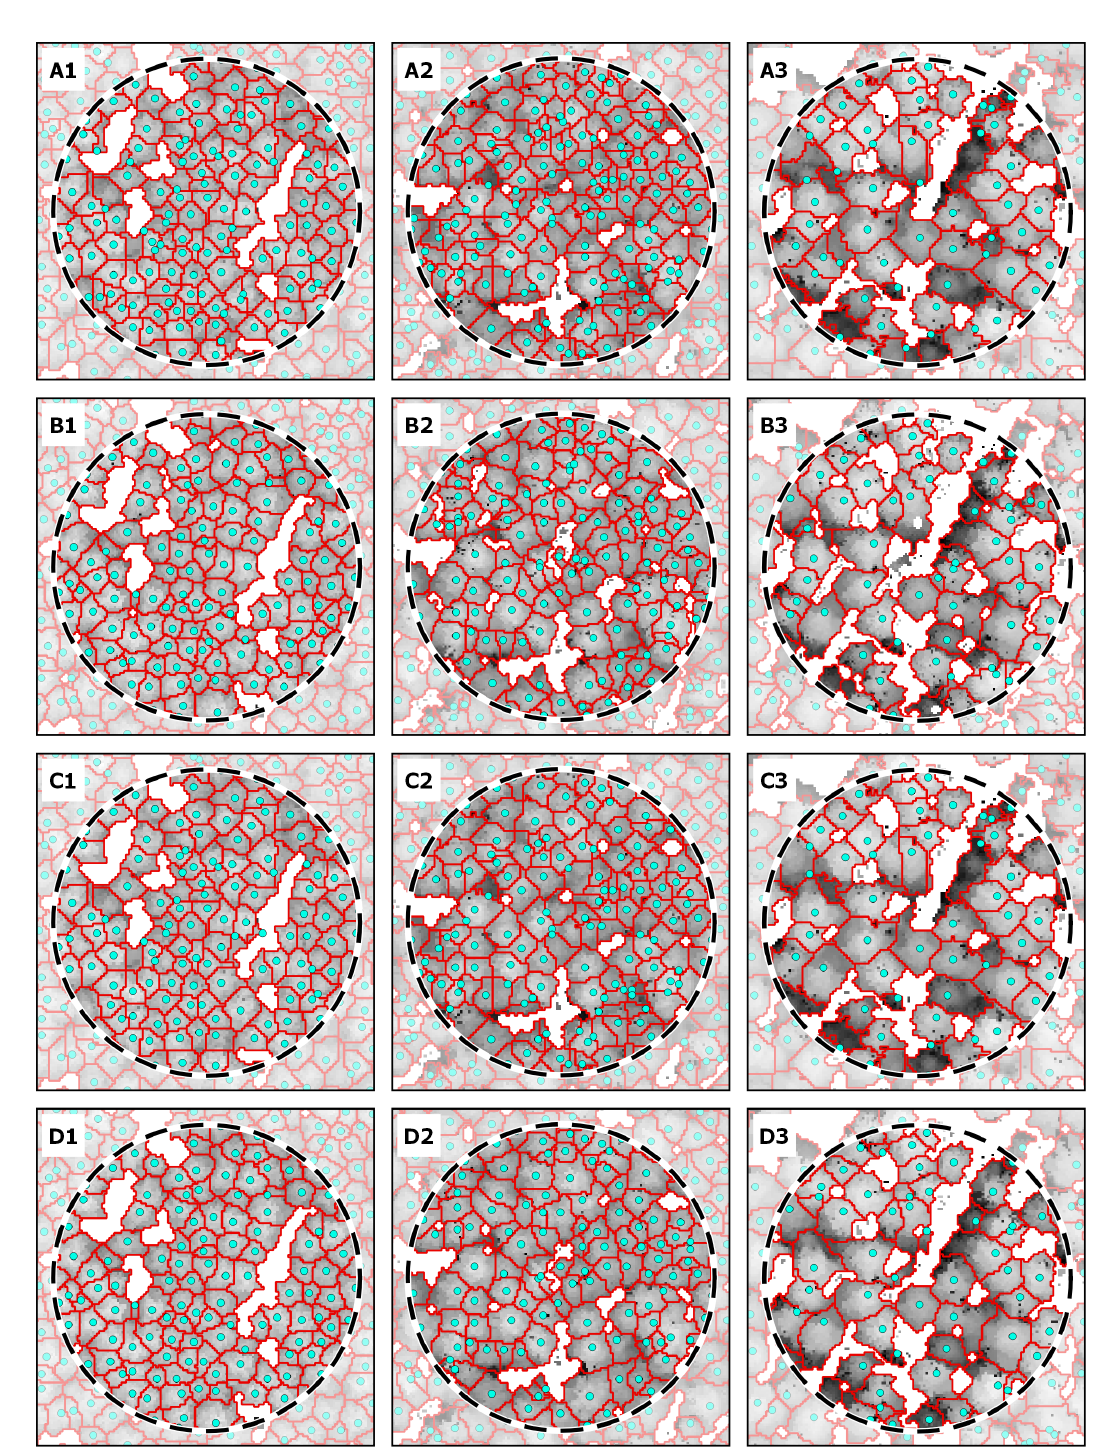
Figure 18. Examples of segmentation of stands and detection of treetops on circular plots characterized by a variable level of difficulty in implementation of the ITD method: 1 —with low diversity of crowns, 2 —with moderate diversity of crowns, 3 —with high diversity of height-dimension of crowns and overlapping crowns. The analysis was performed with both methods with selection of optimal sets of parameters ensuring the minimization of RMSE error ( A —LMF+GR, B —Watershed) and MAPE measure ( C —LMF+GR, D